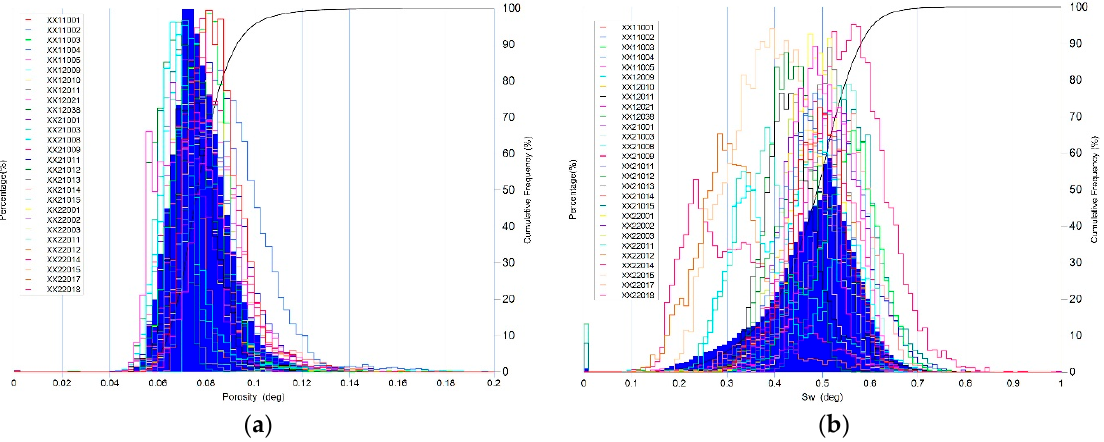
Figure 16. Histograms of porosity and water saturation distributions for logging interpretation of horizontal wells: ( a ) porosity; ( b ) water saturation. The blue filled histogram is the cumulative distribution of all wells.